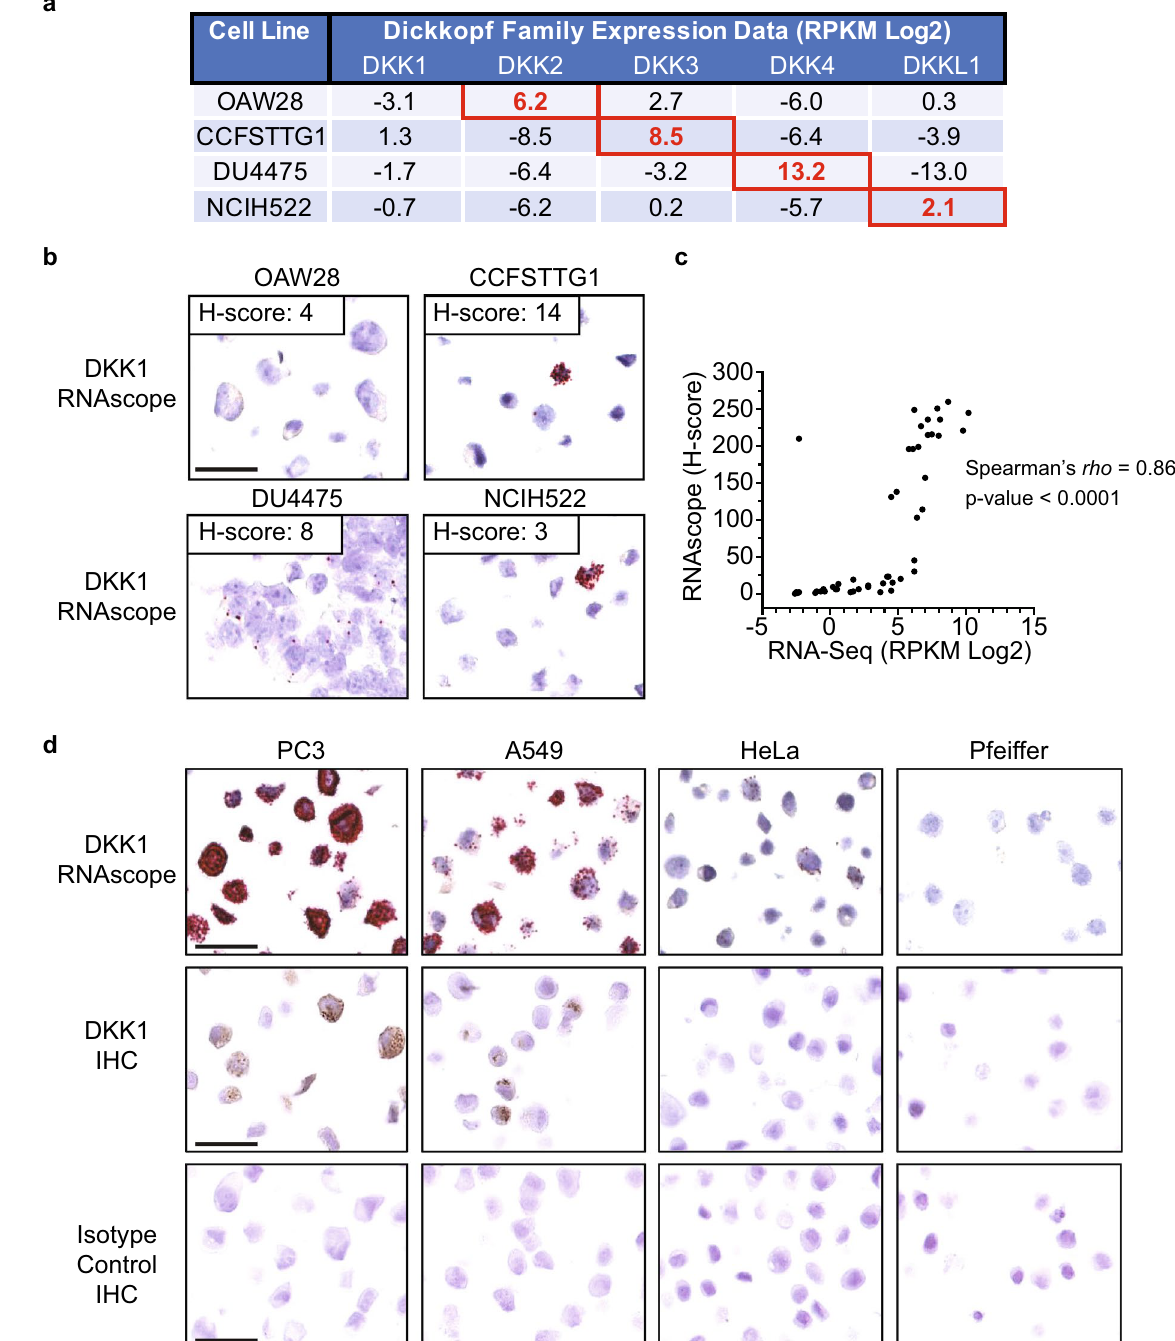
Figure 2. Specificity and accuracy of the DKK1 RNAscope assay. ( a ) Cell lines were identified using RNA-Seq data from the Cancer Cell Line Encyclopedia database that expressed very high levels of the indicated Dickkopf family member and low levels of DKK1. Red boxes denote the expression level of the Dickkopf family member that is highly expressed in the indicated cell line. Reads per kilobase per million mapped reads (RPKM). ( b ) The specificity FFPE cell pellet array with the indicated cell lines was stained for DKK1, quantified using QuPath morphometric software and an H-score (range 0–300) was calculated as described in the methods. Scale bar: 50 μm. ( c ) FFPE cell pellet arrays with different cancer cell lines were stained for DKK1, quantified using QuPath morphometric software and an H-score (range 0–300) was calculated as described in the methods. DKK1 RNA-Seq data was obtained from the Cancer Cell Line Encyclopedia database. Reads per kilobase per million mapped reads (RPKM). ( d ) The indicated cells were stained for DKK1 RNA by RNAscope (top row), DKK1 protein by IHC (middle row) or an isotype control antibody (bottom row). Scale bar: 50